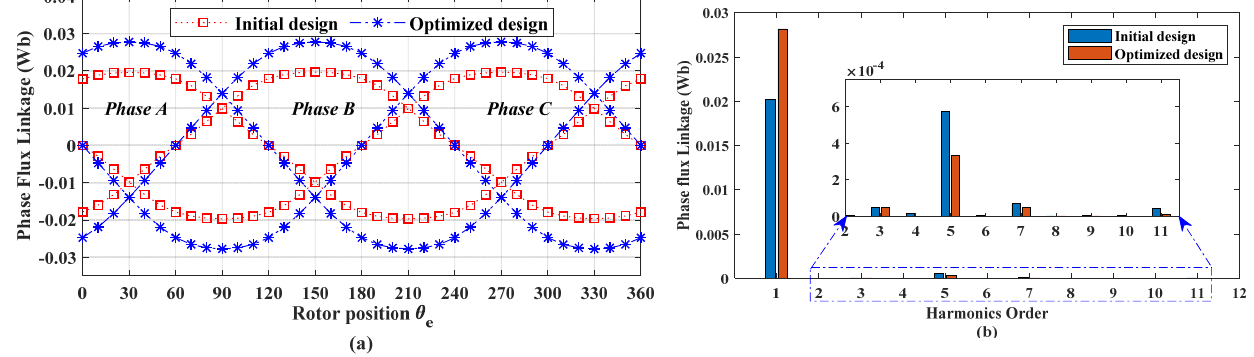
Figure 11. Initial and optimized design phase flux linkage ( a ) waveform and ( b ) harmonic spectra. Under no-load condition, phase-back-EMF and harmonic spectra for initial and opti- mized design through 2D FEA is shown in Figure 12a,b. Analysis reveals that back-EMF is improved by 28%, while odd harmonics and THD is improved by 33.2% and 39.63%, respectively, after optimization. Figure 13 shows the comparison between initial and optimized cogging torque; after optimization, the cogging torque is reduced by 54.93%.